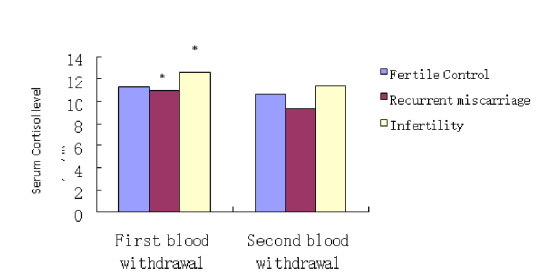
Figure 1: Serum total cortisol (mean±SD) in the first and second blood withdrawal in recurrent miscarriage, infertile and fertile control group. (*) denotes significant differences (p=<0.05): First blood withdrawal vs. Second blood withdrawal.